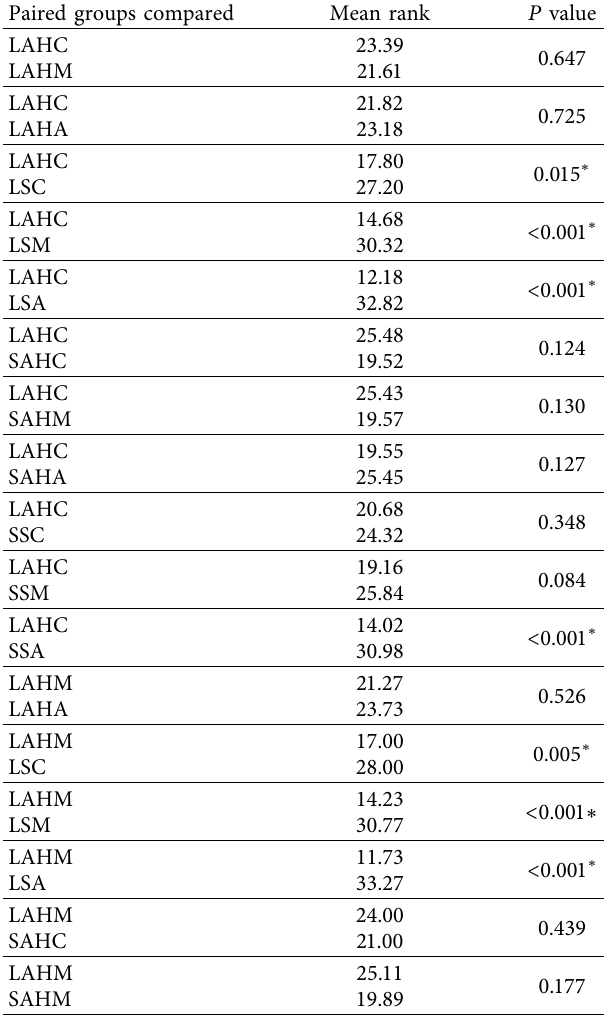
Table 2: Comparison of PBS of the groups (Mann–Whitney U). Paired groups